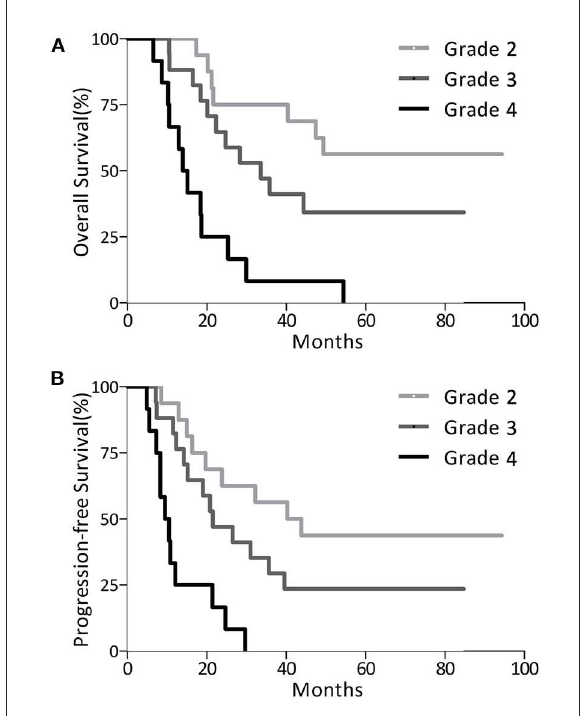
FIGURE2 Survival analysis of glioma patients with WHO grade 2 ( n = 16), grade 3 ( n = 17) and grade 4 ( n = 12). (A) Overall survival analysis curve. (B) Progression-free survival analysis